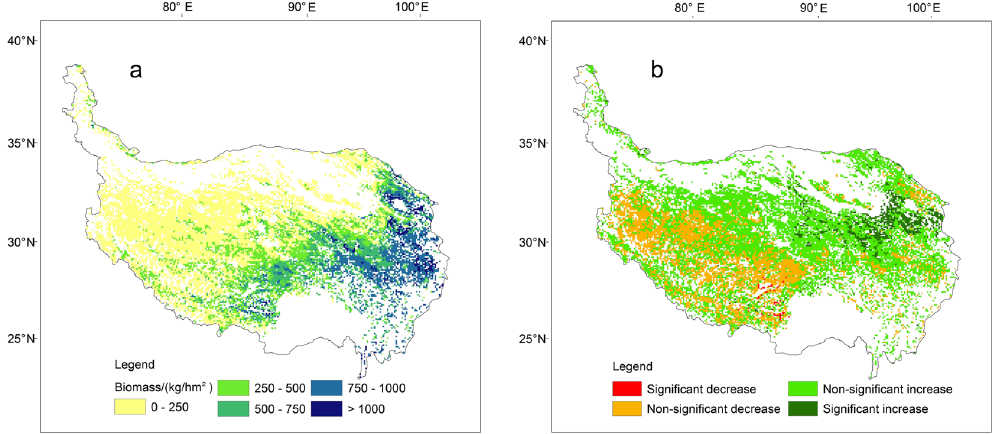
Figure 4. Spatial distribution of the mean aboveground biomass ( a ) and the change trend in estimated aboveground biomass ( b ) from 2000 to 2012 in the grasslands of the Qinghai-Tibet Plateau. The map was edited and generated with ArcGIS 10.2.2, http://www.esri.com/.